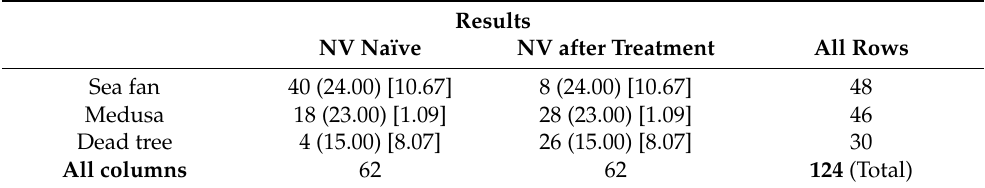
Table 2. Results of the chi-square test.